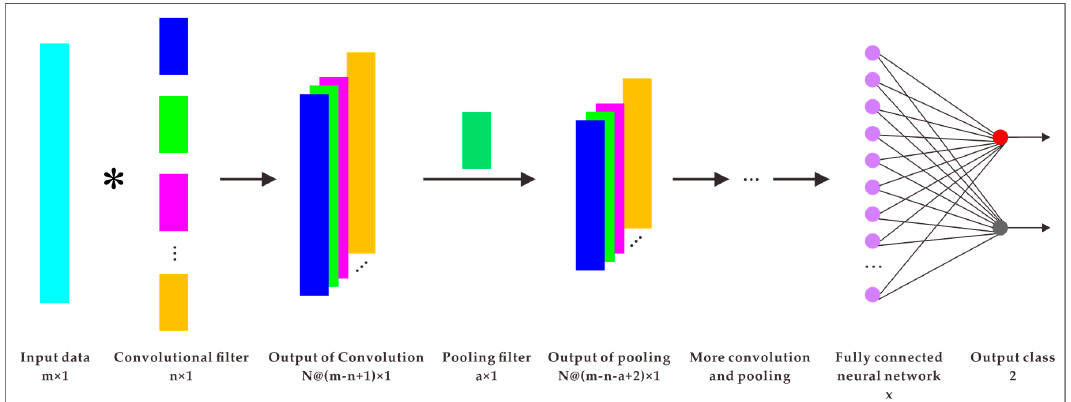
Figure 4. Typical architecture of one ‐ dimensional CNNmodel.